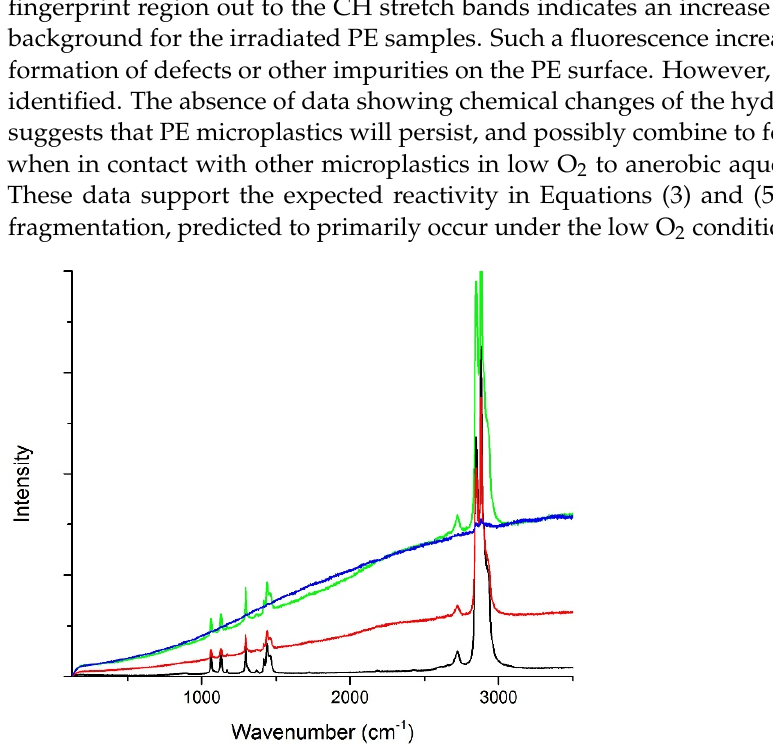
Figure 6. Baseline subtracted high-resolution Raman spectra showing the C ‒ C stretch, CH 2 twisting and CH 2 bending bands of gamma irradiated PE in fresh water (red trace), salt water (green trace), and Lake Michigan water (blue trace) showing minimal changes in comparison to the stock PE (black trace). 4. Conclusions The irradiation of PE microplastics in aqueous environments under low O 2 to anaer- obic conditions showed that the radical-induced processes yielded a variety of aliphatic hydrocarbon scission degradation products. Of these, n -dodecane was dominant, and found in significant excess of its aqueous solubility limit owing to adsorption on the sur- face of the PE microplastics. Such adsorption of hydrophobic degradation products to